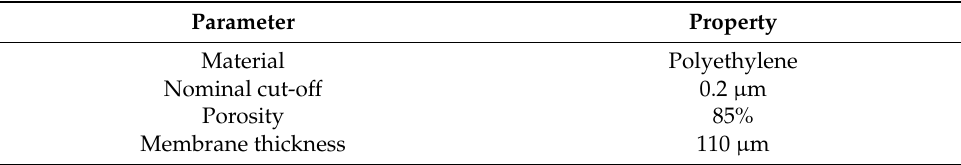
Table 3. Membrane characteristics. Product Datasheet Lydall Performance Materials, “14P02F: Microporous Polyethylene Film”.